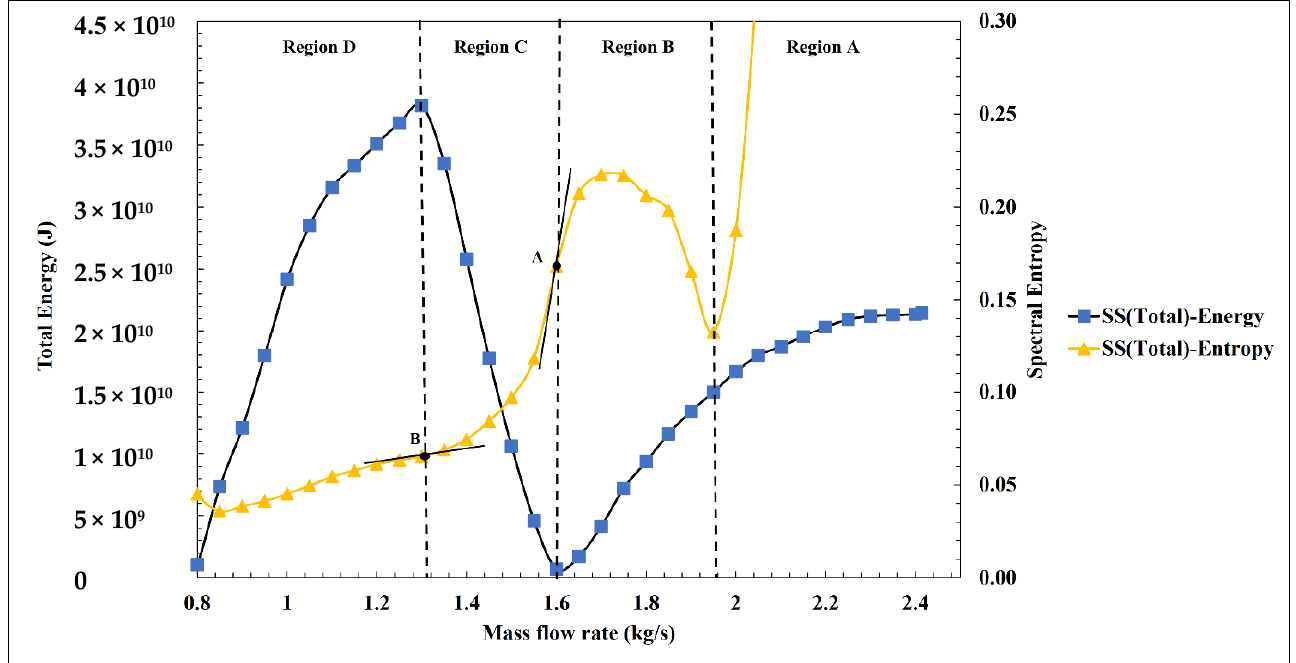
Figure 8. Sum of squares total of total energy and spectral entropy versus mass flow rate.